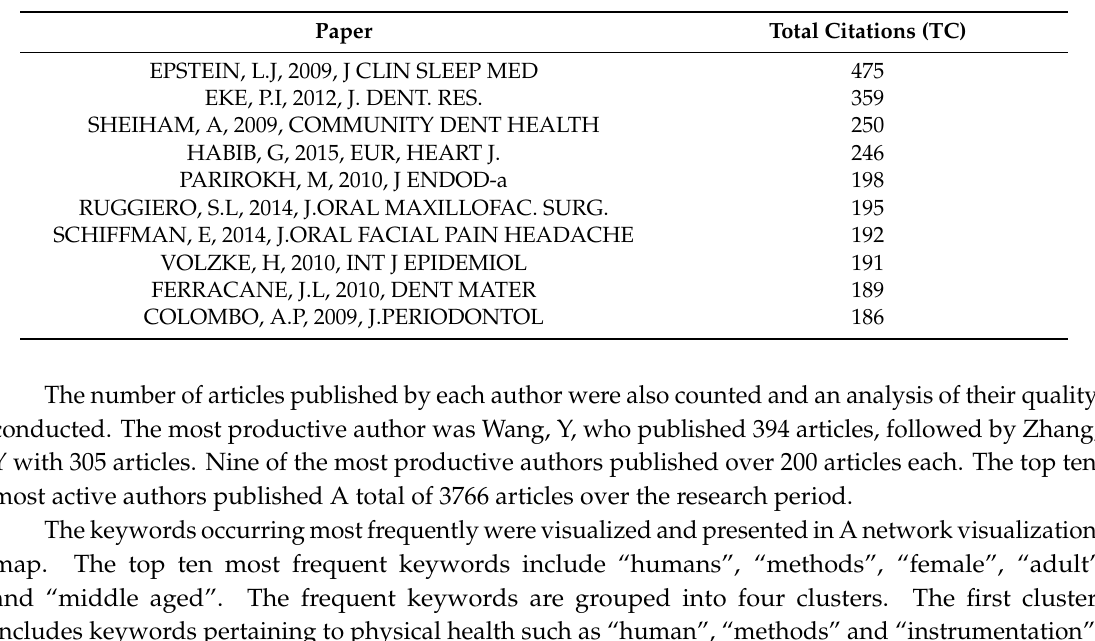
Table 7. Top ten manuscripts with most